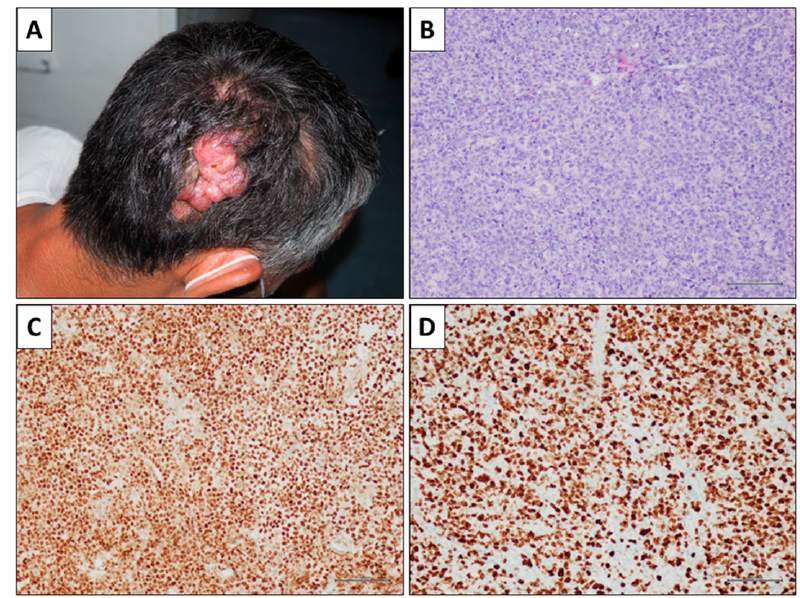
Figure 5. A case of primary cutaneous follicle center lymphoma (PCFCL). ( A ) A 62-year-old man presenting a nodular lesion on the occipital skin. ( B ) Microscopic examination showing a diffuse lymphoid population with large cell morphology (hematoxylin and eosin stain, original magnification 200 × ). ( C ) The neoplastic population expressed bcl6 and the proliferation index (Ki67) was high ( D ) (immunohistochemical stains, original magnification 200 ×